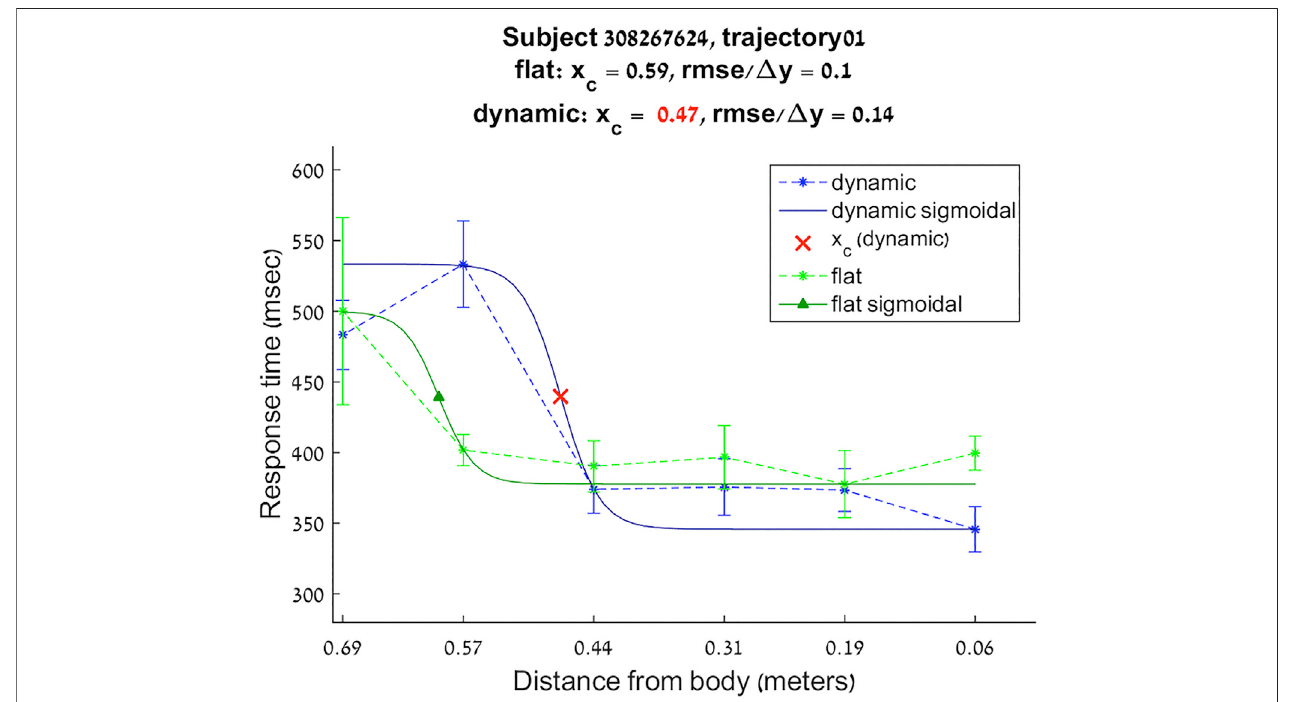
FIGURE 2 | Reaction times sigmoidal approximation for subject 308267624 trajectory 1 fl at and dynamic conditions.